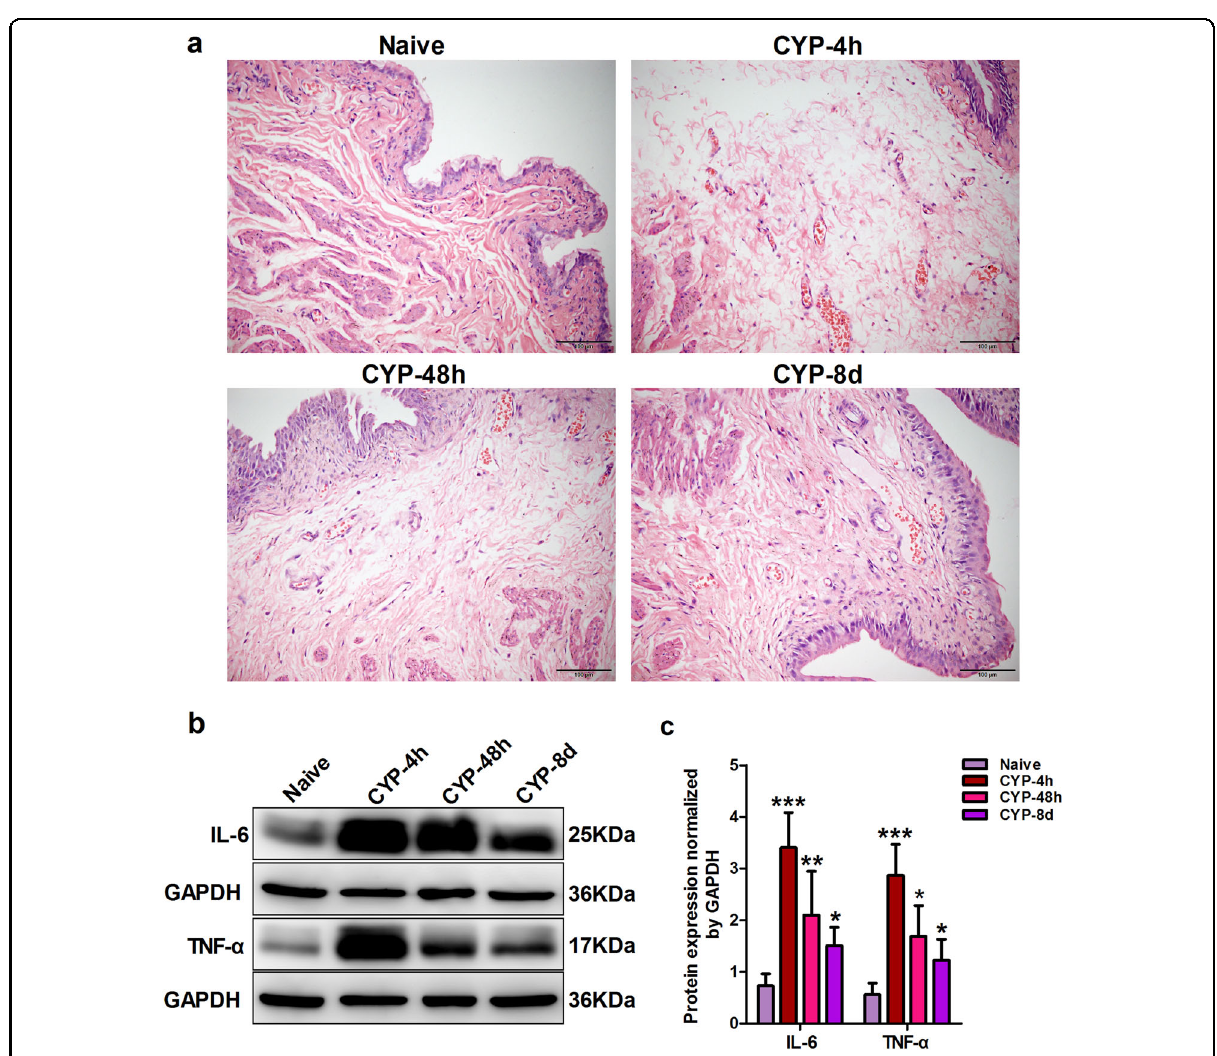
Fig. 1 Cyclophosphamide (CYP) successfully induced acute and chronic cystitis in rats. a Compared with vehicle-treated (naive) rats, characteristic in fl ammation was detected in histological bladder sections from CYP-treated rats. Bladder sections from CYP-4h and CYP-48h rats (acute cystitis models) demonstrated severe edema and hyperemia in the lamina propria, and bladder sections from CYP-8d rats (chronic cystitis model) exhibited moderate edema and hyperemia in the lamina propria accompanied by urothelial hyperplasia. b , c IL-6 and TNF- α protein expression levels in the bladders from CYP-treated rats were signi fi cantly elevated (the data represent the mean±S.D., n = 3; * P <0.05, ** P <0.01, and *** P <0.001, versus naive